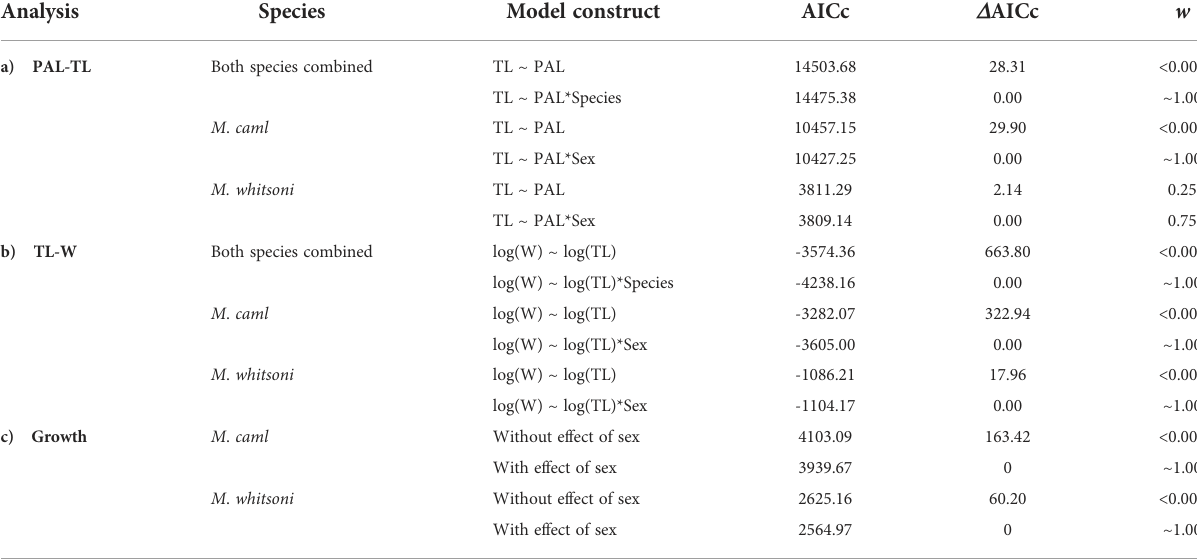
TABLE 1 Summary of fi ts of models used to examine the effects of species and/or sex on a) the relationship between pre-anal length (PAL, cm) and total length (TL, cm), b) TL and weight (W, kg) and c) growth for Macrourus caml and M . whitsoni in the Ross Sea region.